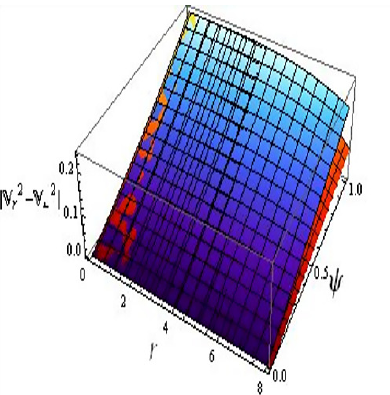
Figure 6. Plots of causality condition and Herrera cracking approach versus ψ and r corresponding to two stellar candidates (Solution II).